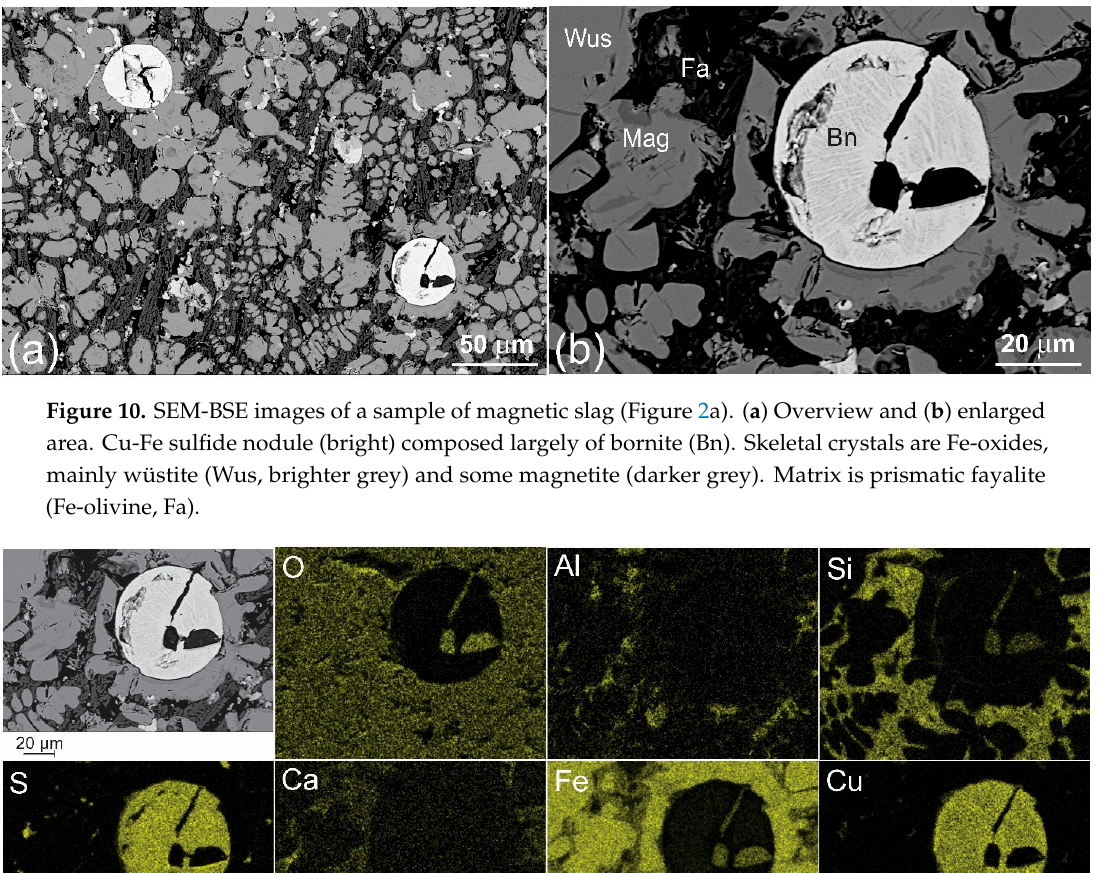
Figure 9. Selected SEM-EDS spectra illustrating composition of non-magnetic Casaccia slag; ( a ) olivine core (from Figure 8a); ( b ) amorphous matrix (from Figure 8a); ( c ) bornite (from Figure 8c); ( d ) pyrrhotite (from Figure 8c); ( e ) native copper (from Figure 8d); ( f ) pentlandite (from Figure 8d). Only K α and L α peaks are labeled; vertical axis is count intensity. Minerals 2019 , 9 , x FOR PEER REVIEW 11 of 20